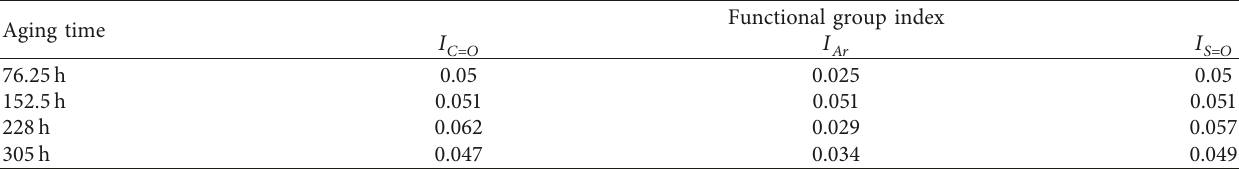
Table 5: Functional group index of 70# base asphalt at different UV aging stages.